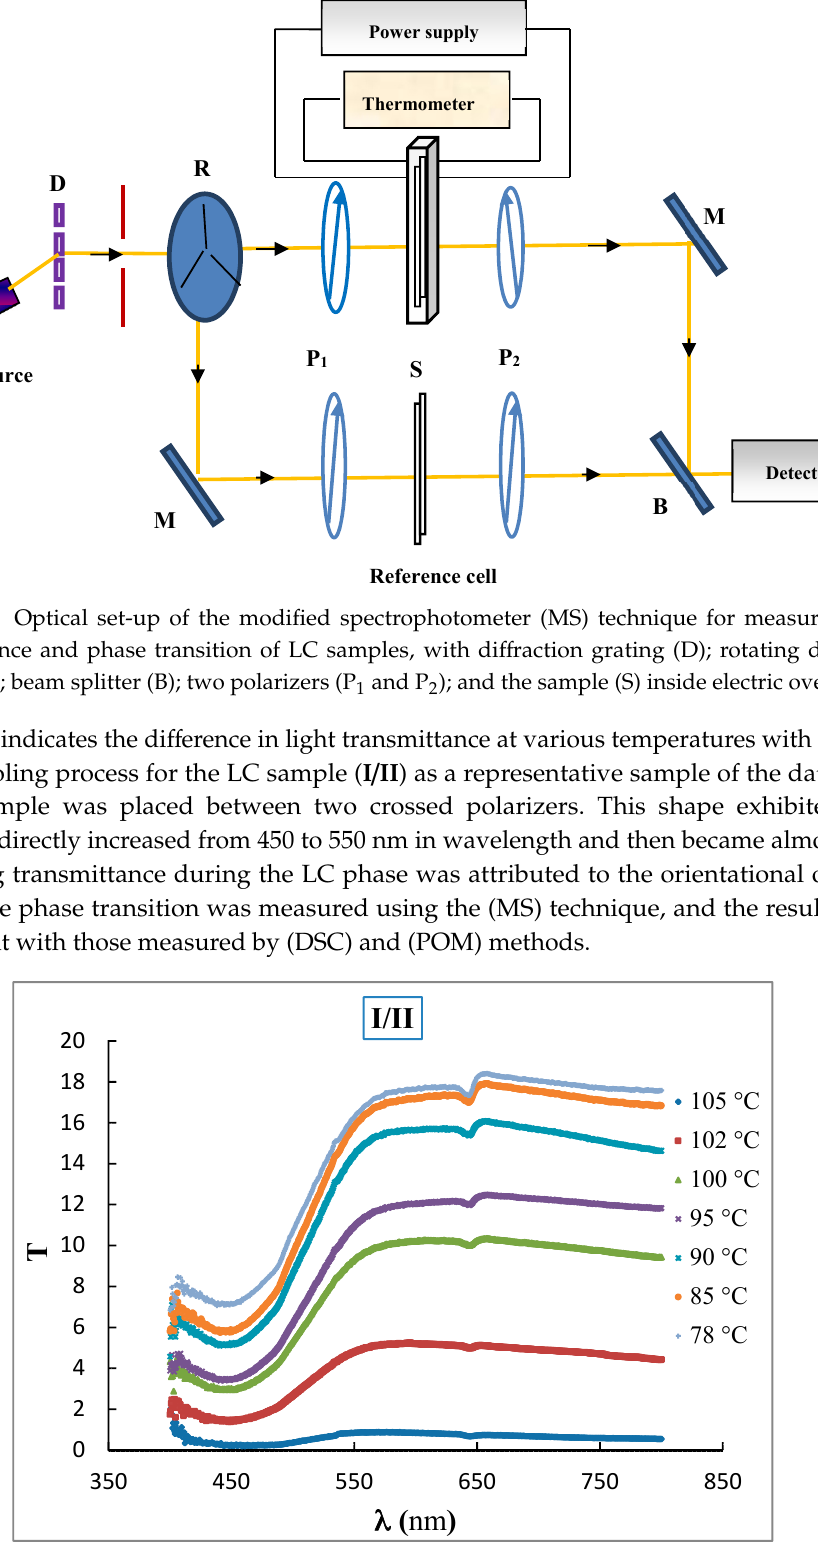
Figure 13. The variable wavelength transmittance for the complex I/II at such temperatures.